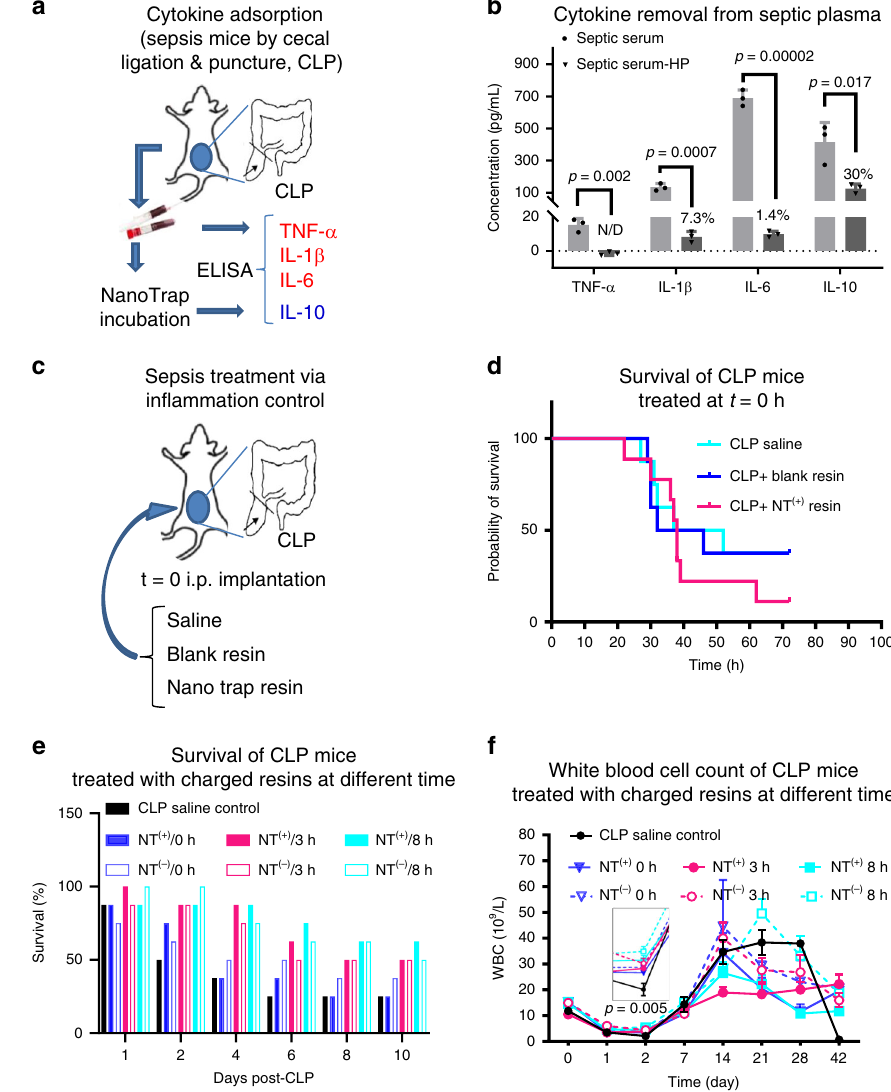
Fig. 5 Immune modulation via TD NT resins. a Schematic illustration of sepsis mouse model induced by cecal ligation and punctuation (CLP) procedure, and septic blood was collected 24 h post CLP for ex vivo bead incubation. b Key cytokines TNF- α , IL-1 β , IL-6, and IL-10 in plasma were quanti fi ed via ELISA assays before and after 2-h incubation ( n = 3, duplicated measurements, mean ± SEM. Statistical signi fi cance was measured by paired one-sided Student ’ s test). c Experimental design of the spontaneous intraperitoneal treatments of CLP mice ( n = 8) with saline, blank PEGA resin, or PEGA-(ArgC17) 4 NT ( + ) resin in situ right after CLP procedure. d The survival of the animal was monitored for 3 days. Surprisingly, higher mortality was observed for spontaneous NT ( + ) treatment, which may be due to the spread of the infection with the disabled innate immune response by effective resin attenuation. e The survival of CLP mice ( n = 8) treated with intraperitoneal implantation of NT ( − ) PEGA-(OAC17) 4 , or NT ( + ) PEGA-(ArgC17) 4 at 0 h, 3 h, or 8 h after CLP without antibiotics. f The white blood cells were monitored for the survived CLP mice in the above treatments over 42 days (statistical signi fi cance was measured by unpaired one-sided Student ’ s test). Source data are available in the Source Data fi